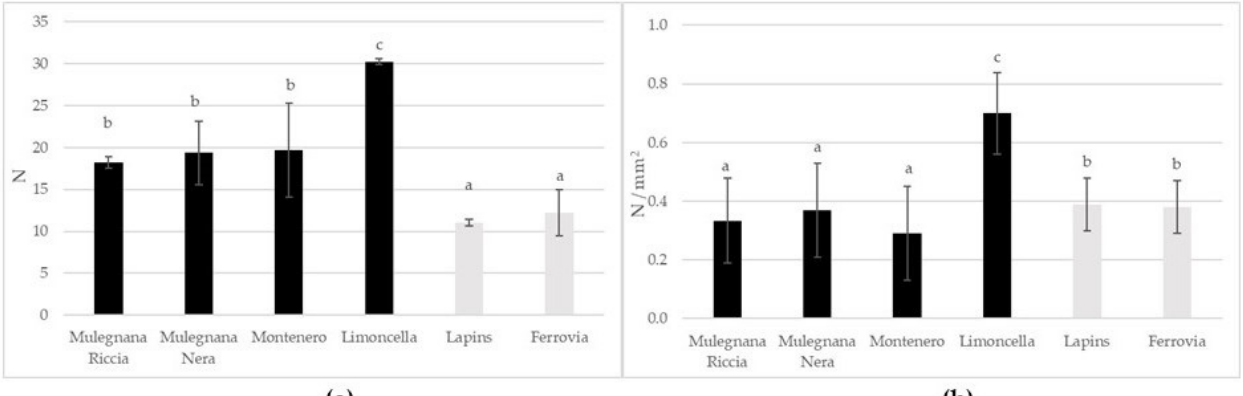
Figure 3. Boundary load (N) ( a ) and Young’s module (N/mm 2 ) ( b ) in the four sweet cherry accessions (Mulegnana Riccia, Mulegnana Nera, Montenero and Limoncella) compared to two standard cultivars (Lapins and Ferrovia). Data represent means ± SD. The same letters indicate non-significant differences (Tukey test) between accessions/cultivars.